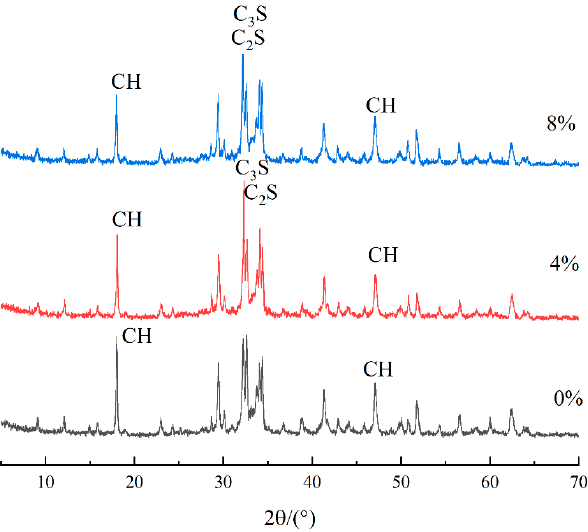
Figure 8. XRD analysis of hydration products.